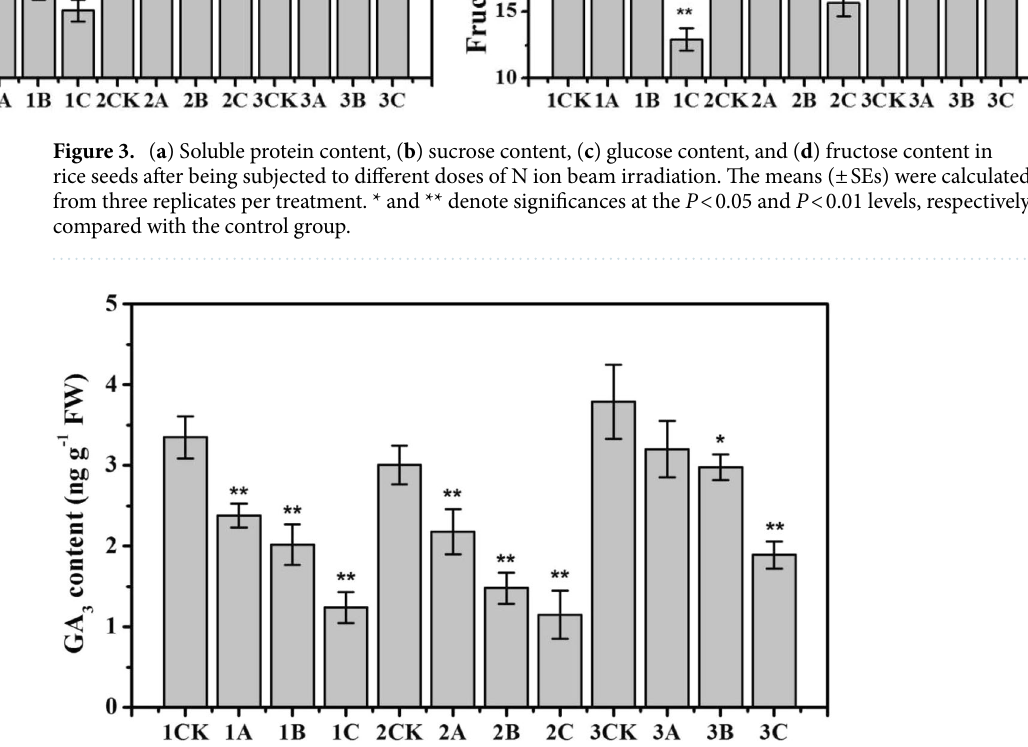
Figure 4. GA 3 content in rice subjected to different doses of N ion beam irradiation. The means (± SEs) were calculated from three replicates per treatment. * and ** denote significance at the P < 0.05 and P < 0.01 levels, respectively, compared with the control